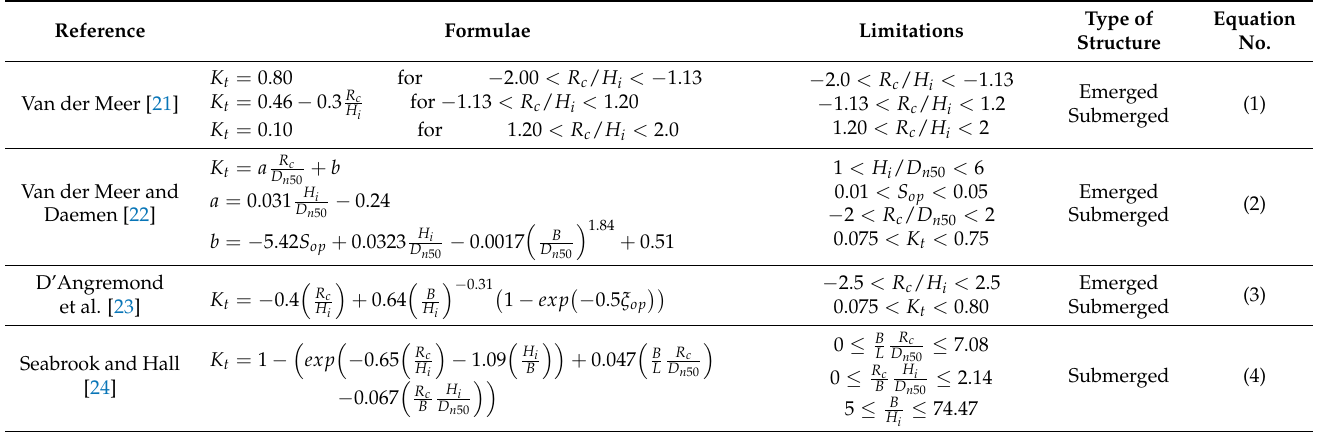
Table 2. Summary of currently most relevant wave transmission coefficient formulae for submerged and low-crested rubble-mound